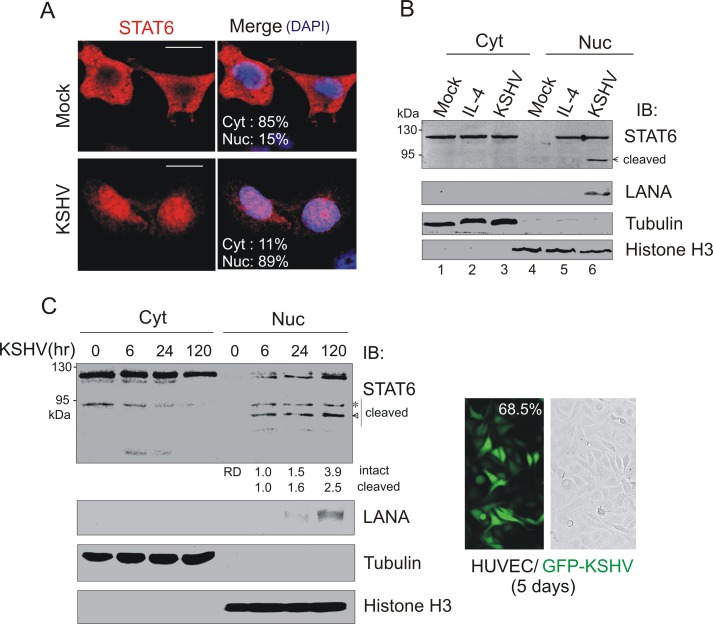
KSHV induces STAT6 nuclear localization.(A) Confocal microscopy of endogenous STAT6 in iSLK stable cells with or without KSHV infection after puromycin selection. Nuclei were stained with DAPI. Scale bars represent 10μM. The average percentage of STAT6 localization in nuclear or cytoplasm compartment was calculated based on observation of fifty-staining cells. (B) Western blot analyses of fractionated proteins from panel A. iSLK cells treated with IL-4 (50 ng/ml) for 30 min were used as positive control for STAT6 nuclear localization. Cyt, cytosolic; Nuc, nuclear, were revealed by α-tubulin, Histone H3, and LANA, respectively. Arrow indicates the major band of cleaved STAT6 induced by KSHV. (C) Western blot analyses of fractionated proteins from HUVEC cells with KSHV primary infection. Asterisk is a specific band of cleaved STAT6 existed in HUVEC cells. The relative density (RD) of intact and cleaved STAT6 proteins in nuclear compartment was quantitated and shown. The average percentage of HUVEC cells with KSHV infection (GFP positive) at 5 days is shown in right panel.